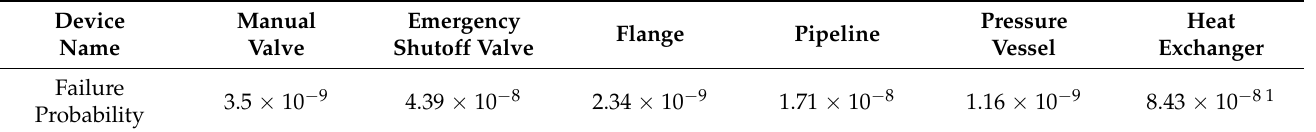
Figure 1. Quantitative risk assessment method for fire risk. Table 1. Probability of different components.